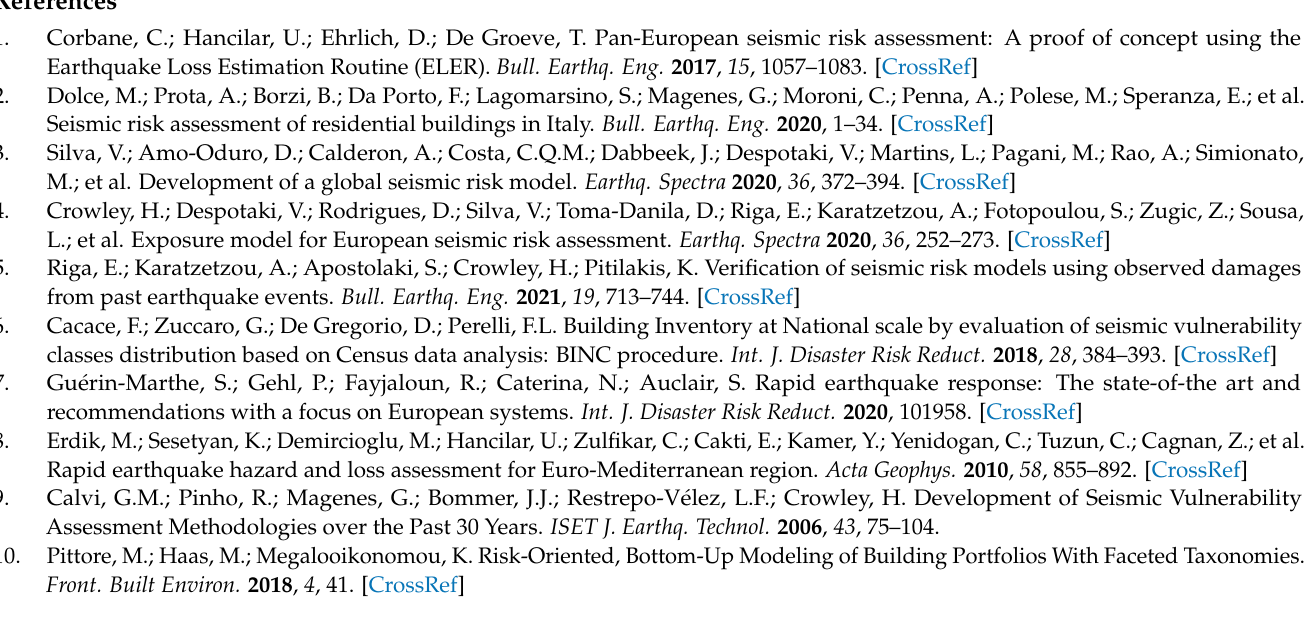
Figure A3. Apartment blocks (type T4 and T5) in the Luchon area constructed around the 1960s and 1970s.